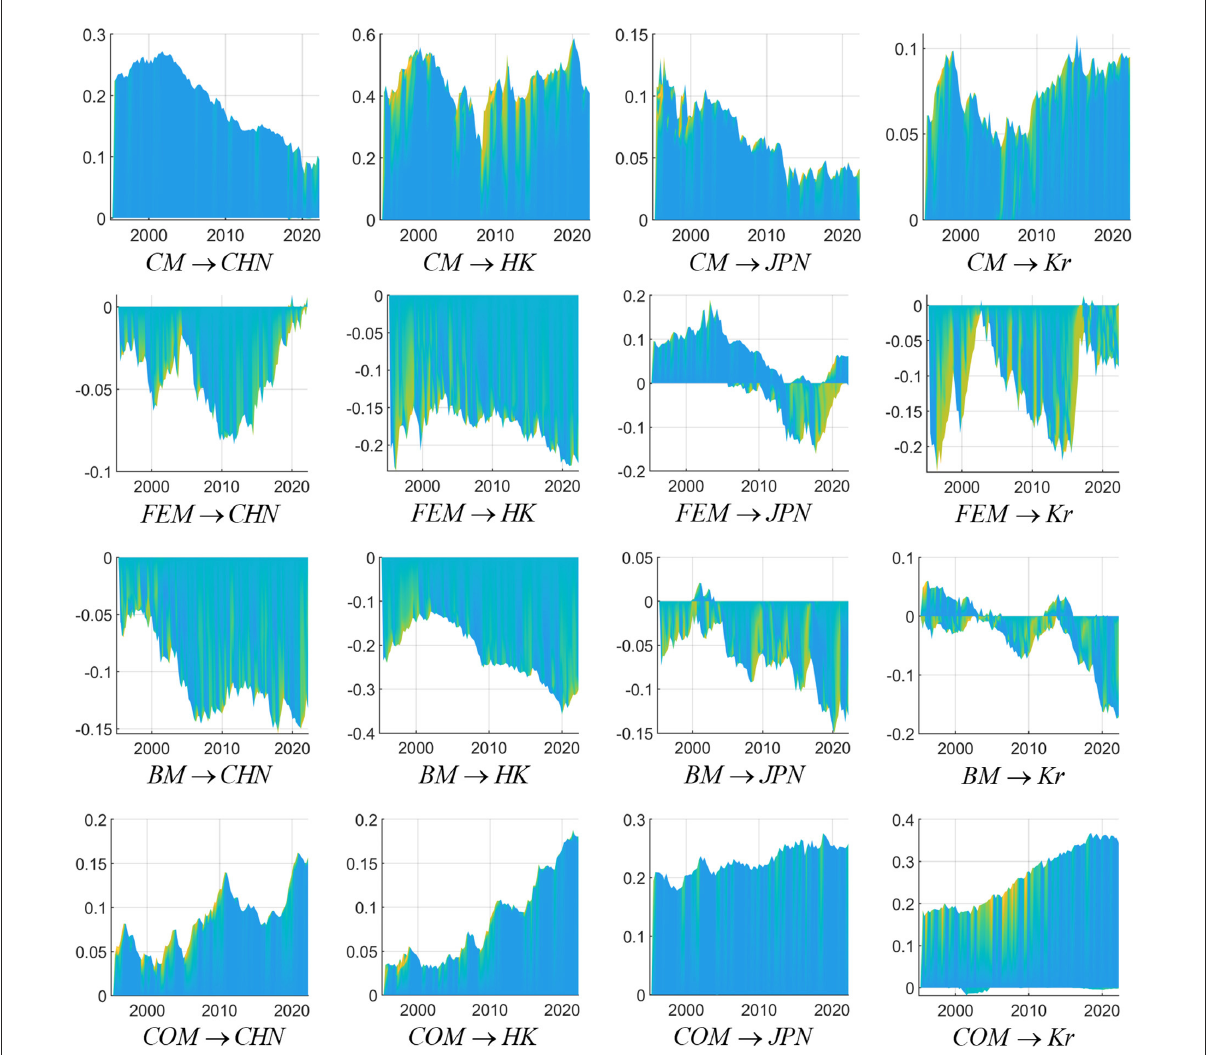
FIGURE6 The interactions between the external financial markets and the stock markets of China, Hong Kong, Japan, and South Korea. Sources: Author’s own calculations. CHN represents China stock market, H.K. represents Hong Kong stock market, JPN represents Japan stock market, and Kr represents South Korean stock market, CM represents commodity markets, FEM represents foreign exchange markets, BM represents bond markets and COM represents crude oil